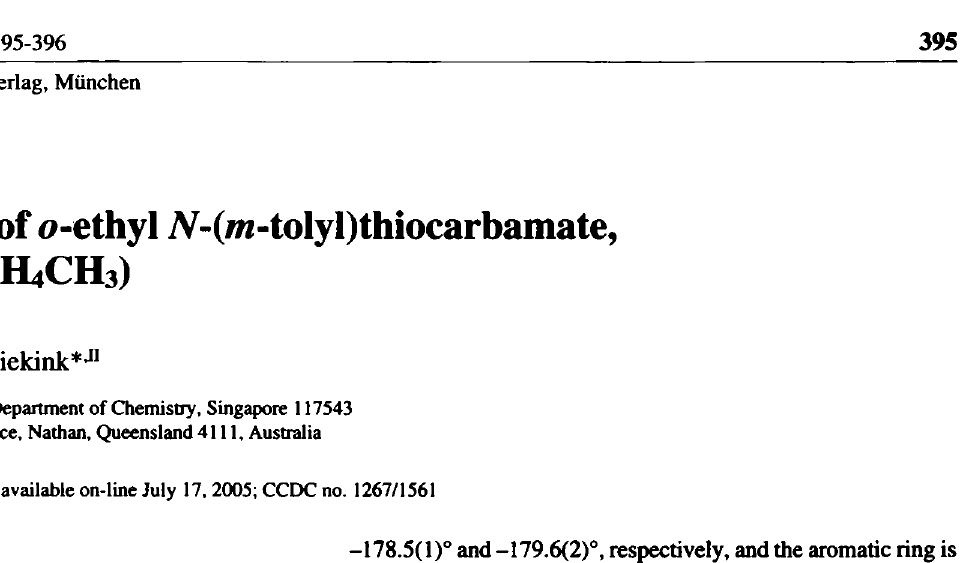
Table 1. Data collection and handling.